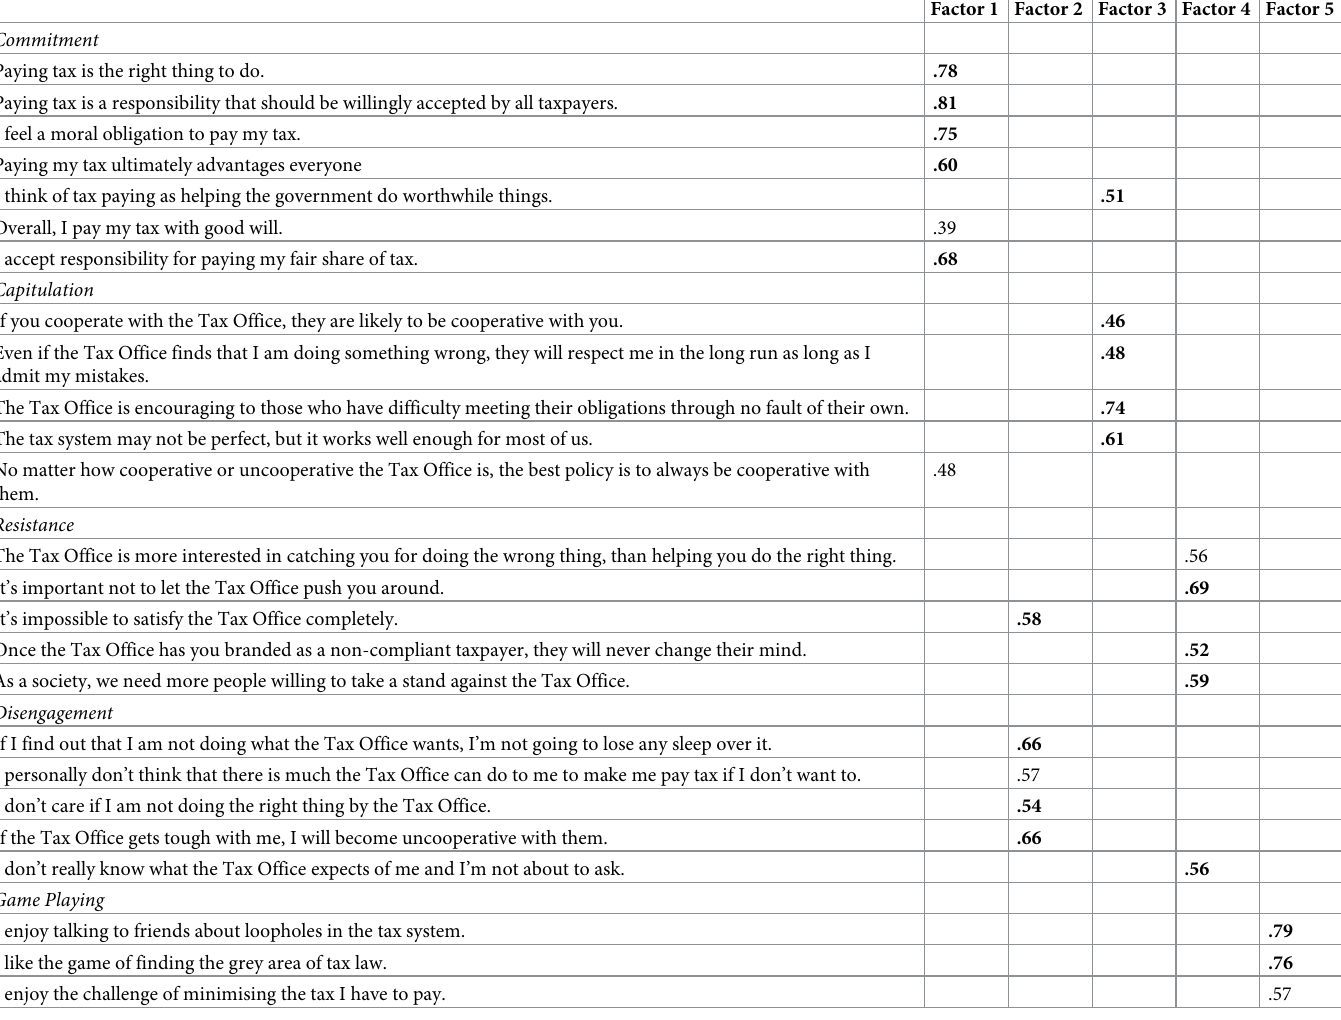
Table 1. Item loadings for the exploratory factor analysis of the Polish version of the